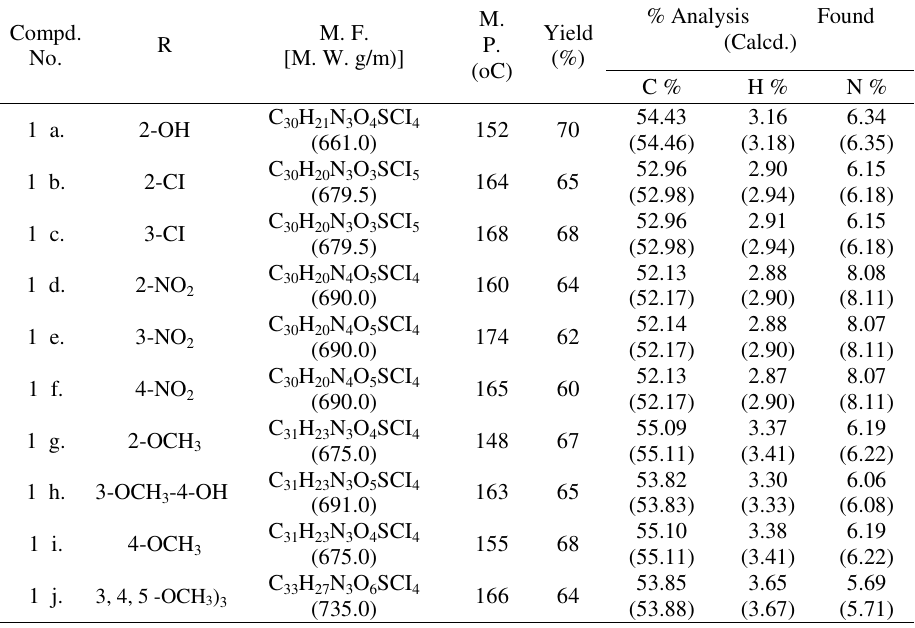
% Analysis Found (Calcd.) Compd.